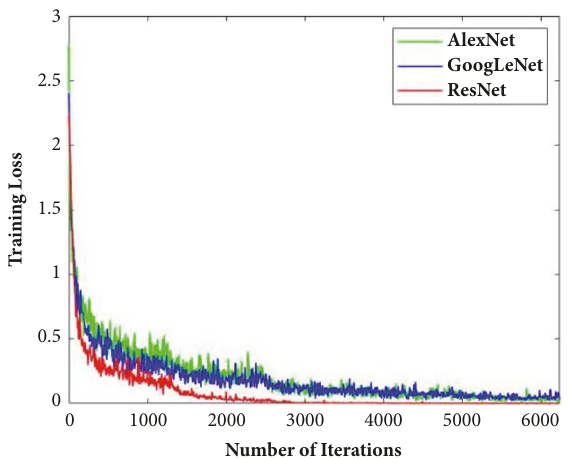
Figure 6: The training loss during the fine-tuning